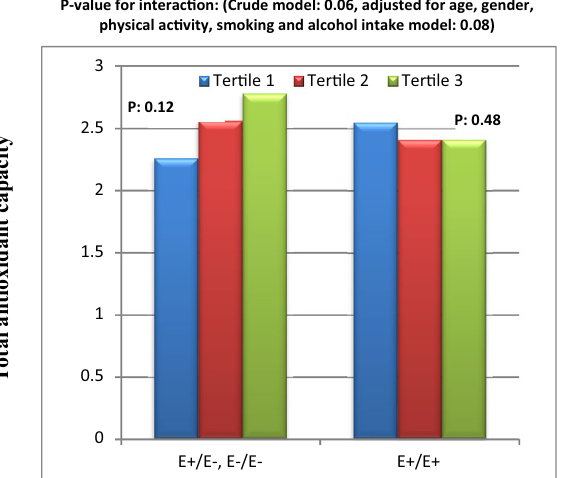
Figure 4. Interaction between Apo B EcoR1 SNP and DQI-I on serum total antioxidant capacity.